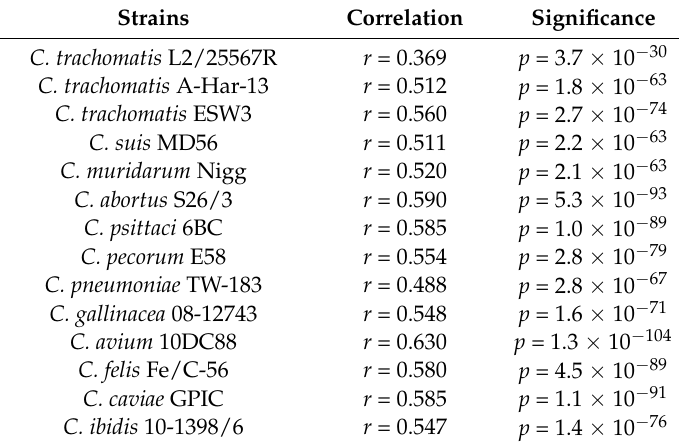
Figure 4. The relationship between the overall codon usage patterns represented by ENC values and GC composition at the third synonymous codon position (GC3) at gene levels of the Chlamydia spp. ( a ) C. trachomatis L2/25567R, ( b ) C. trachomatis A-HAR-13, ( c ) C. trachomatis E/SW3, ( d ) C. suis MD56, ( e ) C. muridarum Nigg, ( f ) C. abortus S26/3, ( g ) C. psittaci 6BC, ( h ) C. pecorum E58, ( i ) C. pneumoniae TW-183, ( j ) C. gallinacea 08-12743, ( k ) C. avium 10DC88, ( l ) C. felis Fe/C-56, ( m ) C. caviae GPIC, ( n ) C. ibidis 10-1398/6. Table 2. The correlation analysis for the effective number of codons (ENC) value and GC3 content of Chlamydia spp.